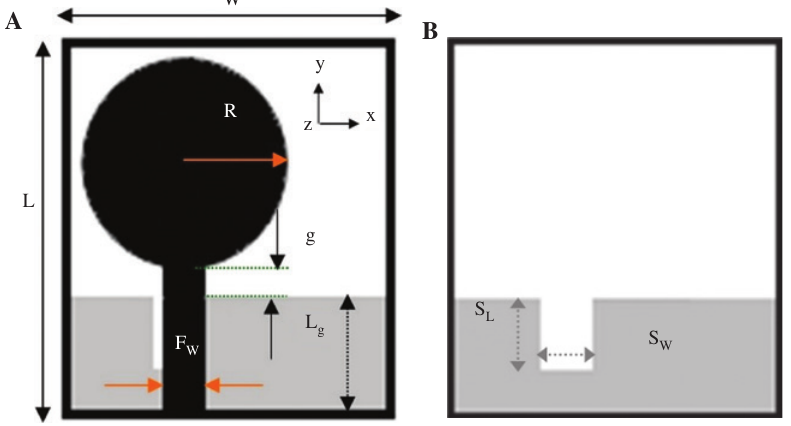
Figure 1: Proposed antenna structure: (A) front view and (B) back